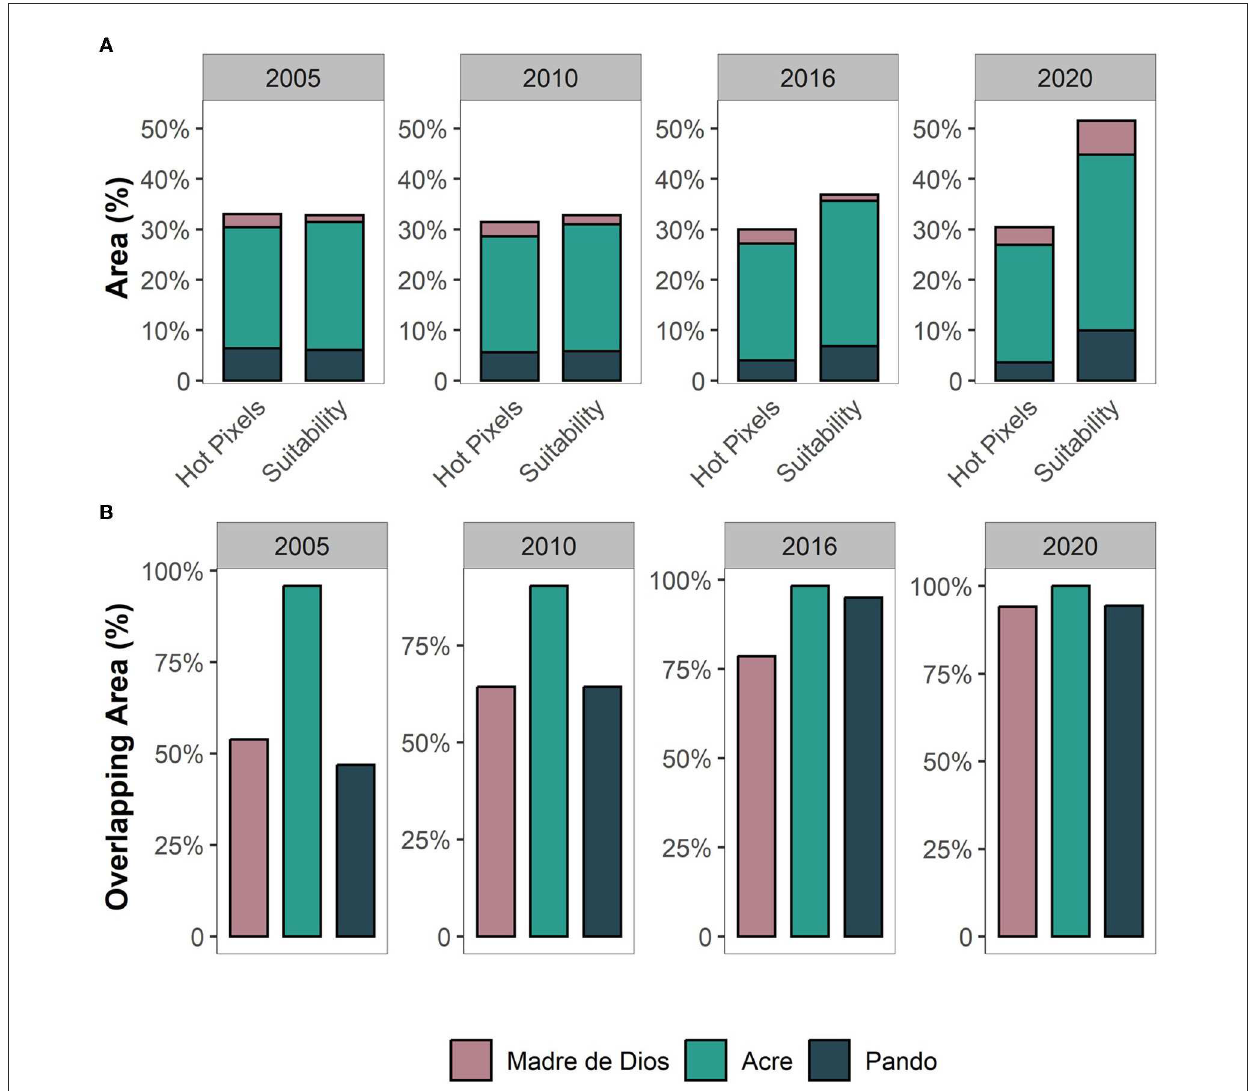
FIGURE6 Comparison between models and actual fires. (A) Percentage of fire-prone areas and fire records in the MAP region. (B) Percentage of grid cells with fire risk that overlaps actual